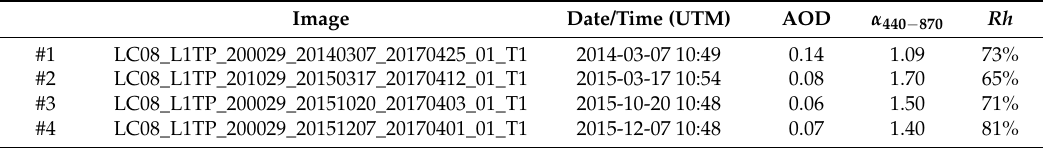
Table 1. Landsat-8/Operational Land Imager images used in this study, with image identifier, date